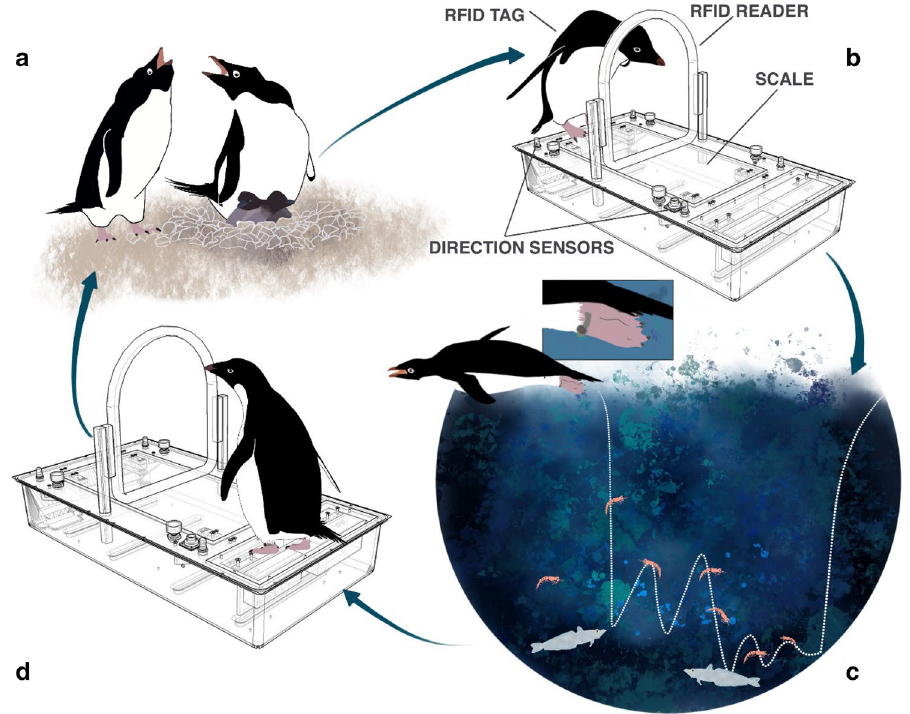
Figure 2. Conceptual visualization of the study design. ( a ) chick-rearing Adélie penguins breeding in a semi- enclosed subcolony are implanted with a RFID tag and equipped with a leg-mounted time-depth recorder (GDR). ( b ) Bird ID, departure mass and direction of travel are recorded by the weighbridge as penguins leave the colony to forage at sea. ( c ) During the foraging trip, the GDR tag records depth every second, enabling the calculation of several dive behavior metrics. ( d ) Bird ID, return mass and direction of travel are recorded by the weighbridge as penguins return to the colony to feed their